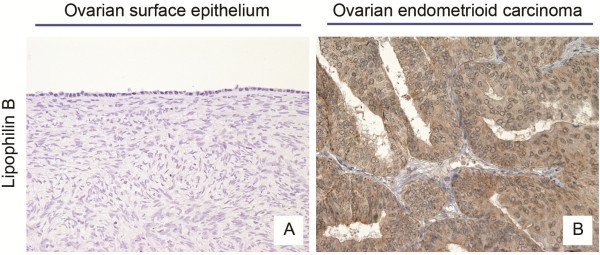
Lipophilin B immunohistochemical staining in epithelial ovarian cancers (EOC) compared to normal ovaries (NO). Immunohistochemistry showed no expression in normal ovaries (A), while it displayed a predominant staining in the cytoplasm of ovarian carcinoma cells (B).